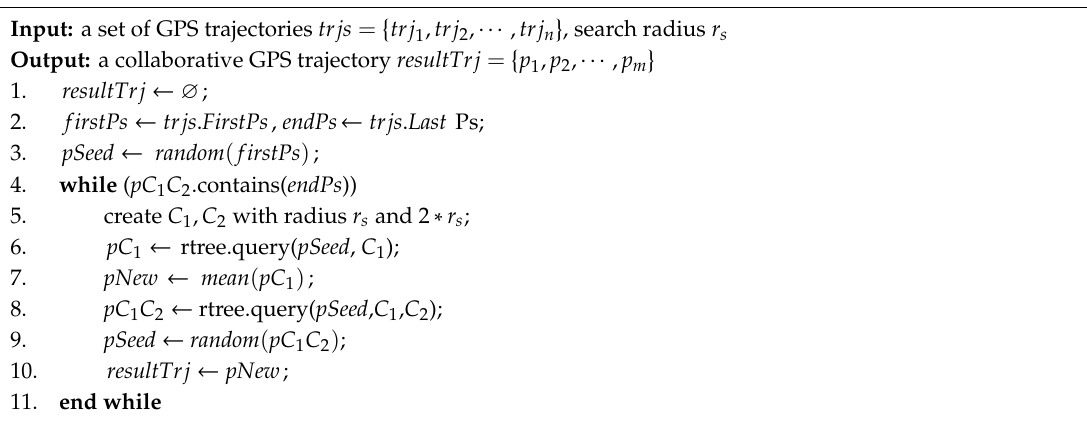
Algorithm 3: Sliding-Window Algorithm for Trajectory Resampling Algorithm 3 : Sliding-Window Algorithm for Trajectory Resampling